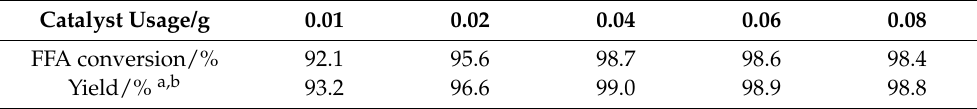
Table 1. The effect of the catalyst usage on the reaction. Catalyst